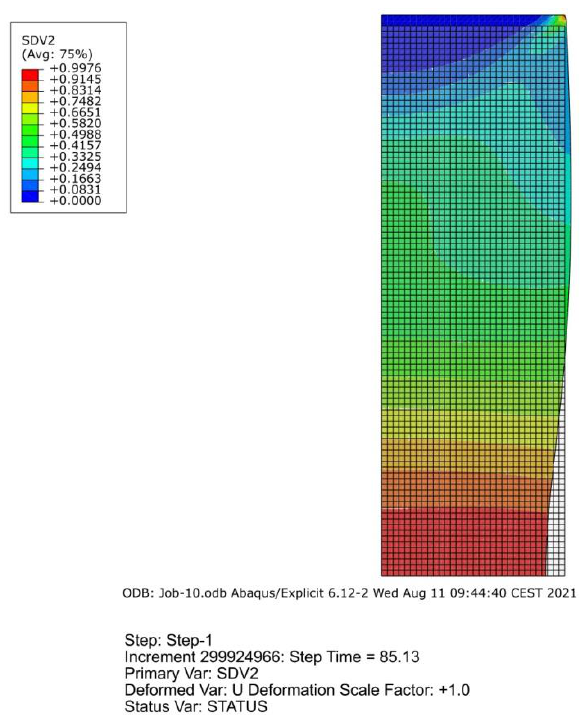
Figure 23. Smooth specimen shape at the final stage.